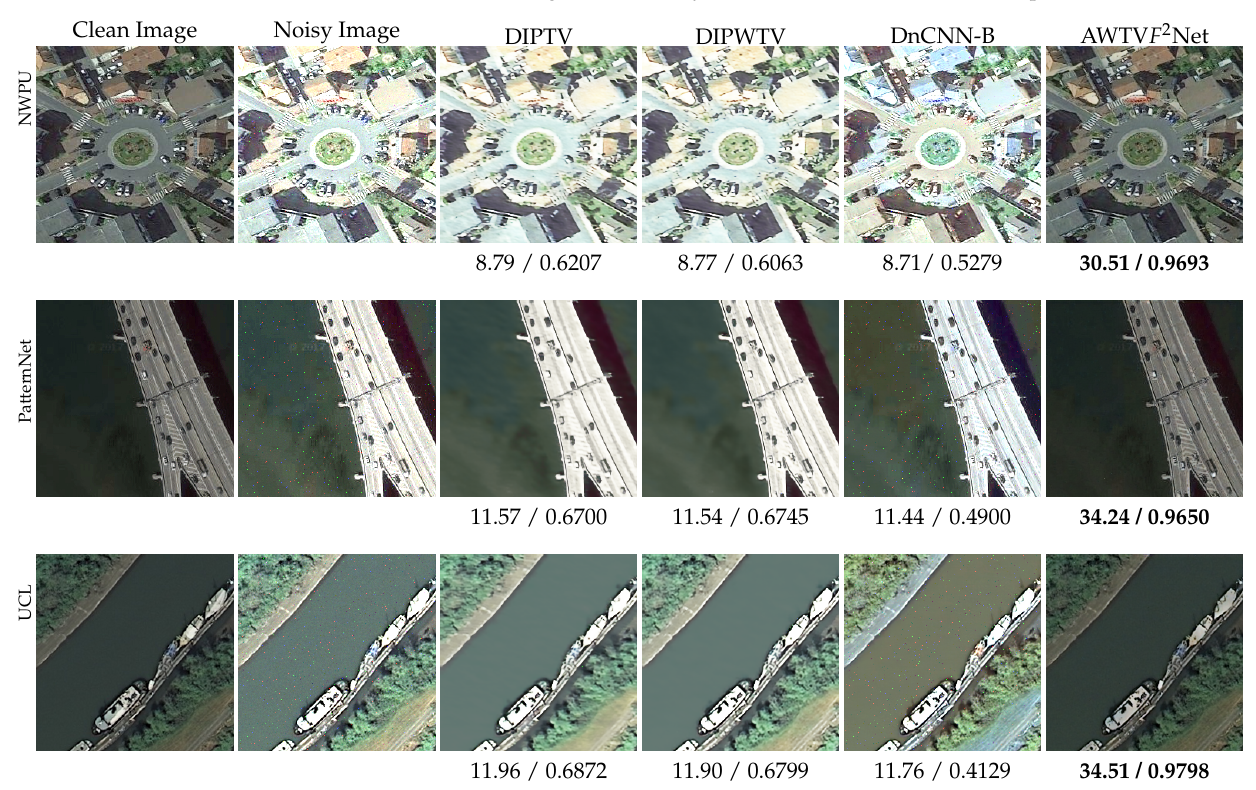
Figure 16. Denoised images distorted by mixture noise of Gaussian and Speckle.